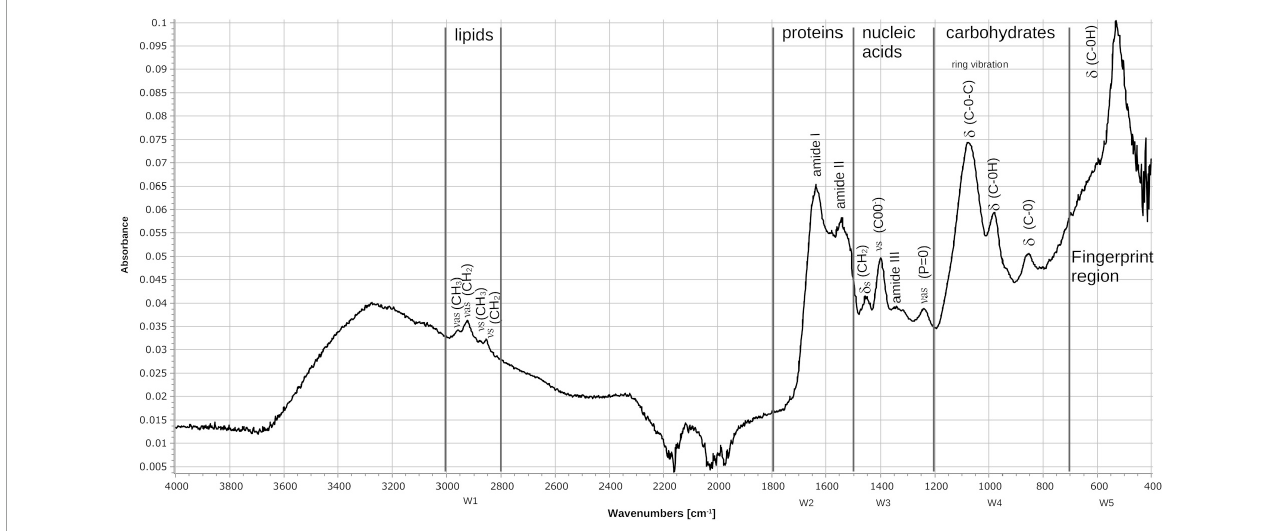
FIGURE11 Fourier transform infrared (FT-IR) spectrum of the FM-825 strain of N. brasiliensis isolated from a mycetoma patient. The absorbance spectra were collected between 4000 and 400 cm − 1 at a spectral resolution of 4 cm − 1 with 50 coadded and averaged scans and 50 background scans. The typical spectrum of bacteria is observed showing the assignments of the main signals within the spectral windows (W1 – W5). (v) stretching vibrations, (d) bending vibrations, (s) symmetric vibrations, (as) asymmetric vibrations.